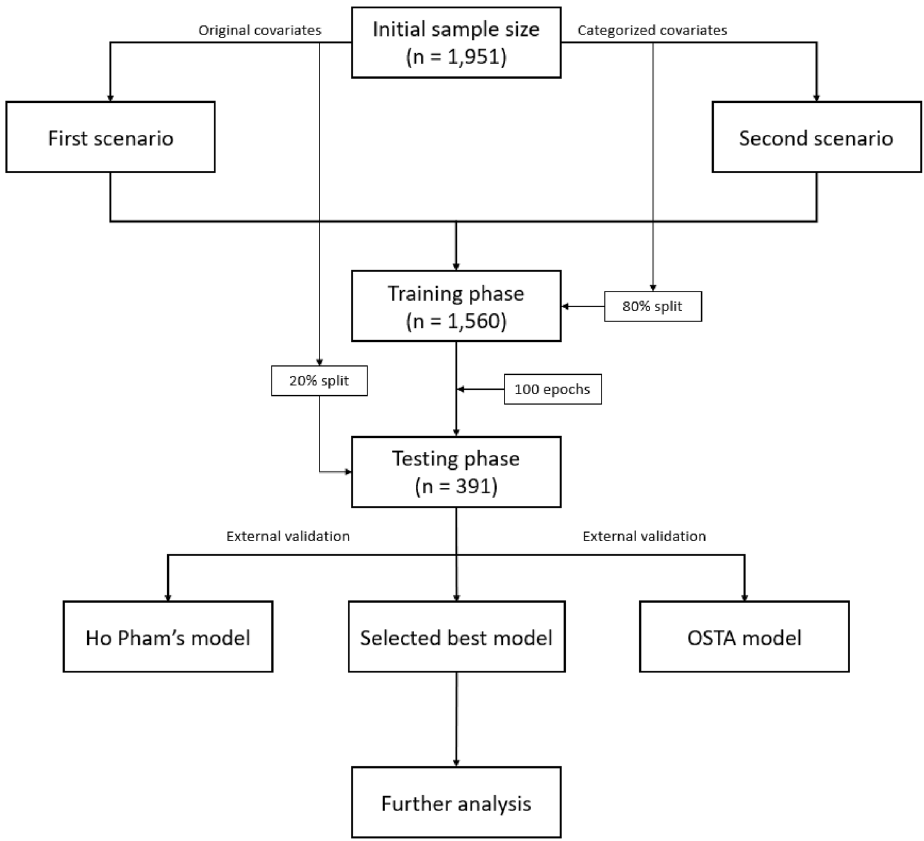
Figure 1. The diagram of the study procedure.